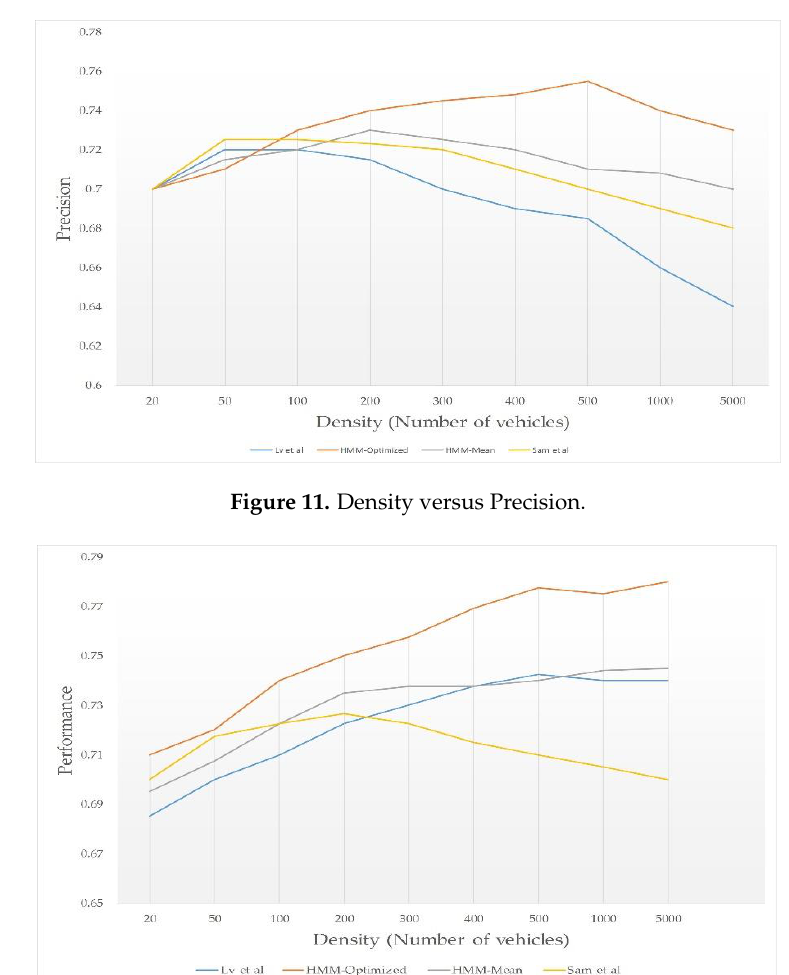
Figure 12. Density versus Performance.